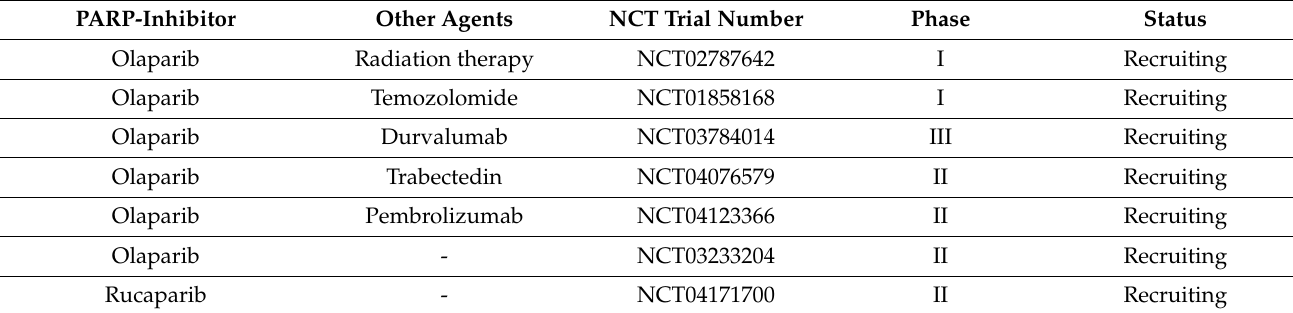
Table 4. Selected PARP-inhibitor trials in sarcoma